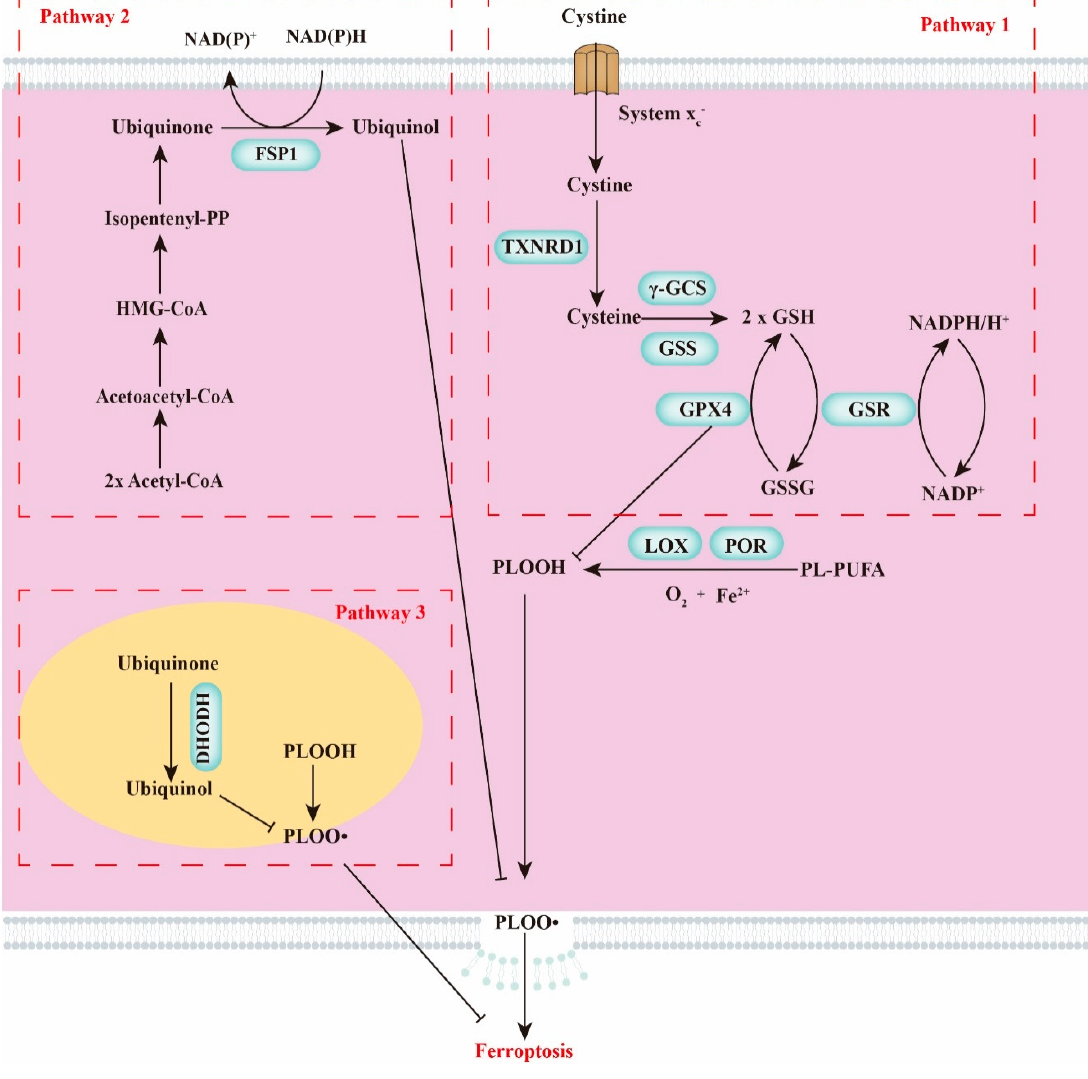
Figure 1. General view of ferroptosis. Footnote: Ferroptosis is triggered by the accumulation of oxidized and toxic phospholipids. This figure presents the three potential regulatory pathways of ferroptosis. TXNRD1, cysteine by thioredoxin reductase 1; γ -GCS, γ -Glutamylcysteine synthetase; GSS, glutathione synthetase; LOX, lipoxygenase; POR, P450 oxidoreductase; GSS, glutathione synthetase.